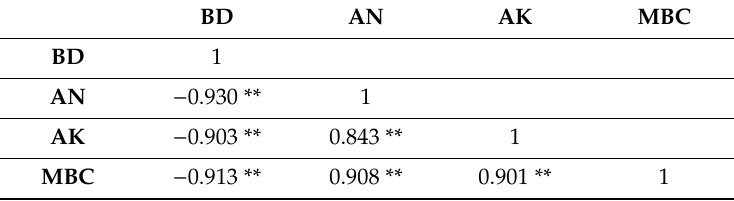
Table 5. Correlations between the highly loaded variables of